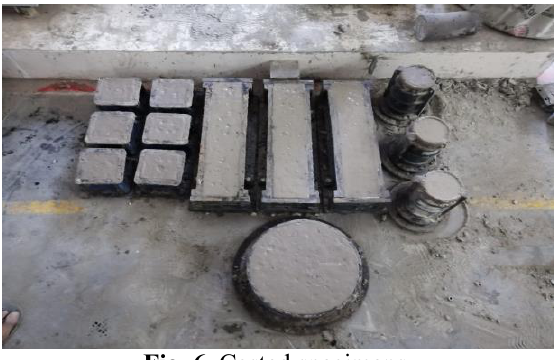
Fig. 6. Casted specimens.